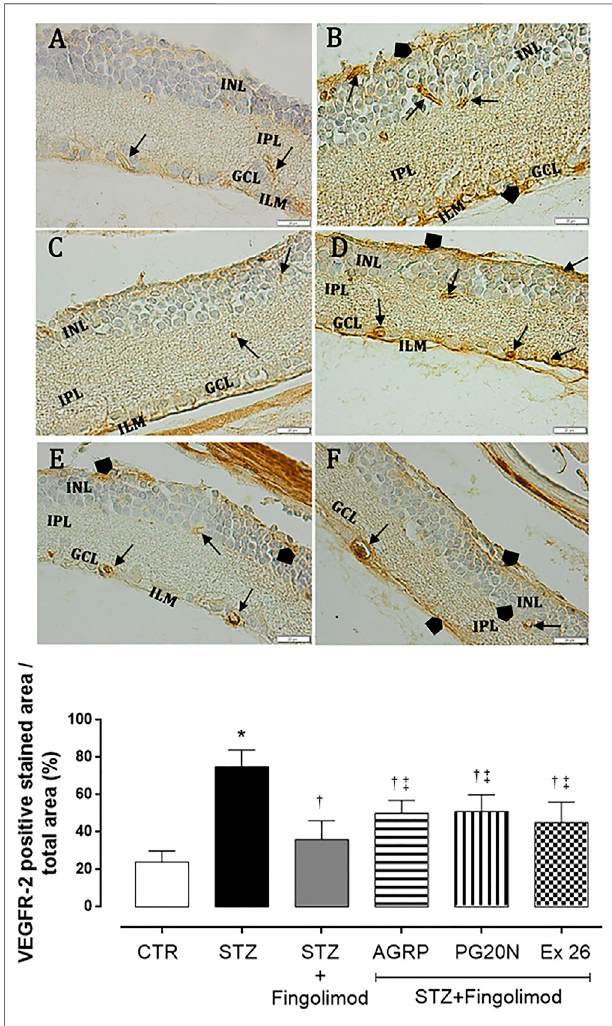
FIGURE4| VEGFR2 immunohistochemistryintheretinaofnon-diabetic mice [panel (A) , CTR], diabetic mice [panel (B) , STZ], diabetic mice receiving fi ngolimod alone [panel (C) , STZ + Fingolimod] or in combination with MC1R antagonist [panel (D) , STZ + Fingolimod + AGRP], MC5R antagonist [panel (E) ,STZ+Fingolimod+PG20N],andSP1R1antagonist[panel (F) ,STZ + FTY720+Ex 26]. VEGFR2 positive stain (arrow). VEGFR2 protein levels are reported as percentage (%) ± S.D. of positive stained area/total area. The imagesarerepresentativeof10histologicalobservationspergroup.Statistical signi fi cance was assessed by one-way ANOVA, followed by Tukey ’ s multiple comparison test. * p < 0.05 vs CTR; † p < 0.05 vs STZ; ‡ p < 0.05 vs STZ + Fingolimod. INL, inner nuclear layer; IPL, inner plexiform layer; ILM, inner limiting membrane; GLC, ganglion cell layer; retinal microvessels staining of VEGFR-2 (arrow), non-vascular staining of VEGFR-2 (arrowhead); magni fi cation 40X; scale bar: 20 µm. N (cid:1) 5 retinas per group.